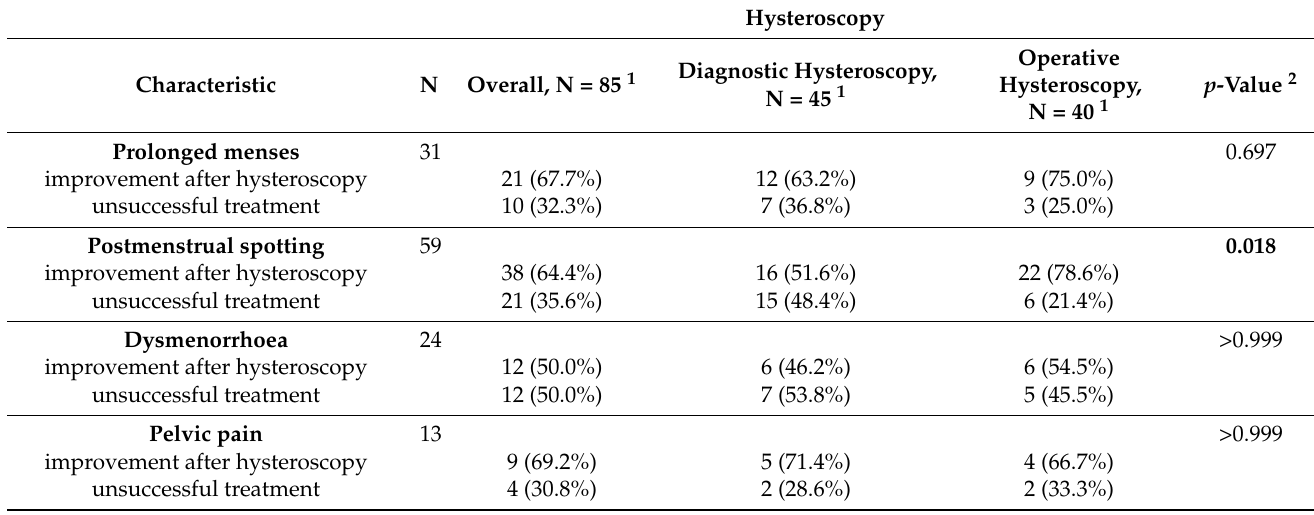
Table 1. The diagnostic vs. operative hysteroscopy and their influence on the reported symptoms.